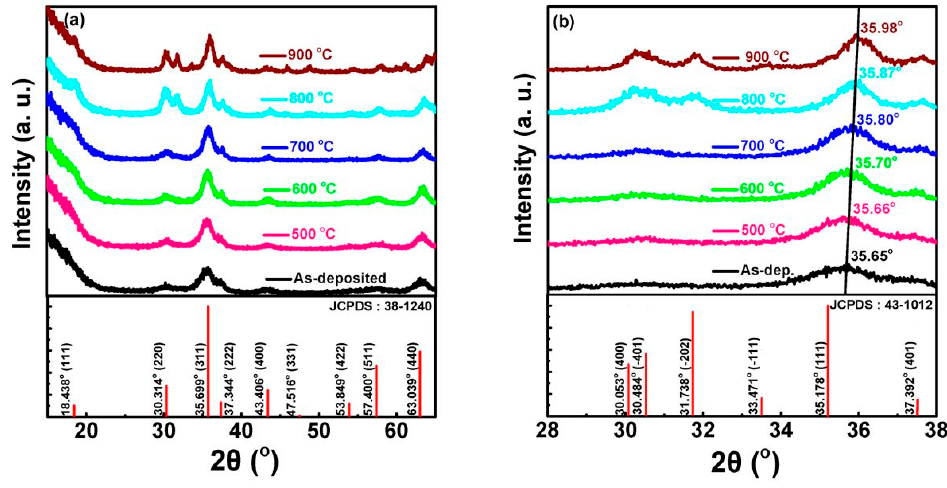
Figure 14. ( a ) XRD spectra of ZnGa 2 O 4 films at different annealing temperatures; ( b ) XRD spectra of ZnGa 2 O 4 showing a limited 2 Theta range (28° to 38°) [74].